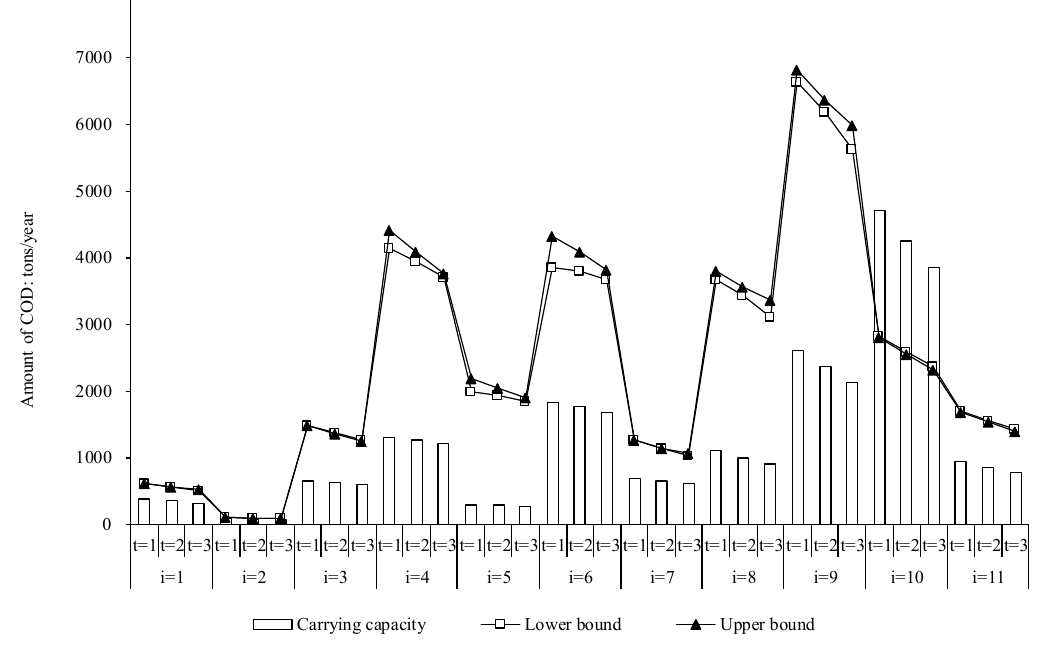
Figure 7. Relationships between carrying capacity of COD and quantity inlets to the Yinma River.